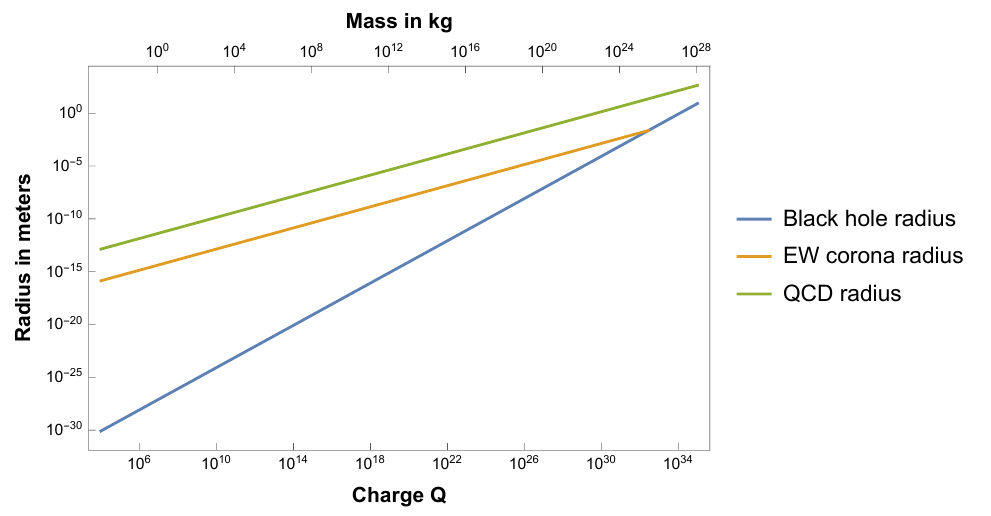
√ r w r h ) (2.9). We also plotted the radius of the c ∼ r e ∼ r ew